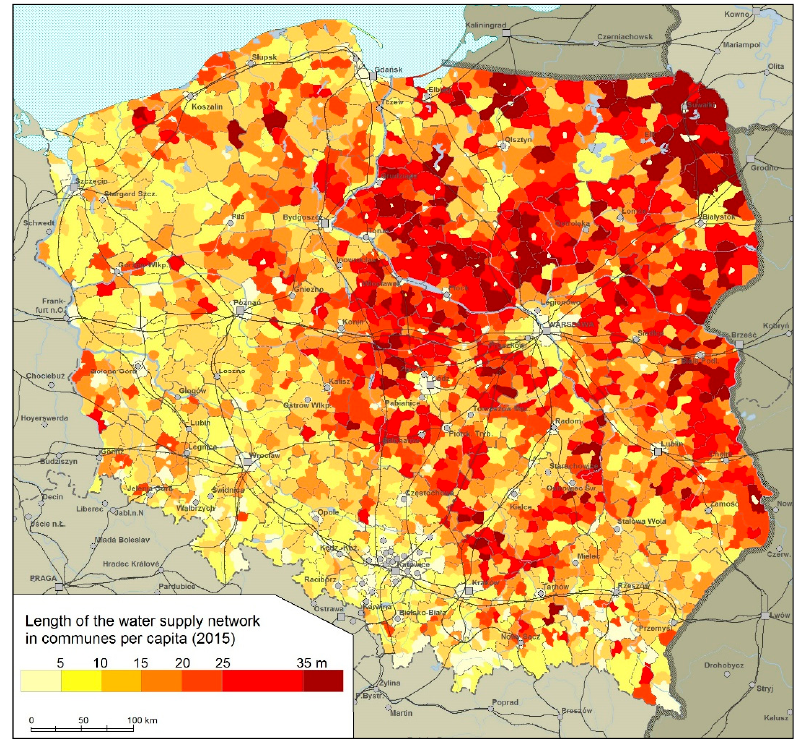
Figure 4. Length of water supply network per capita as a measure of socio-economic efficiency and costs of spatial chaos. Source: based on Central Statistical of Poland data.